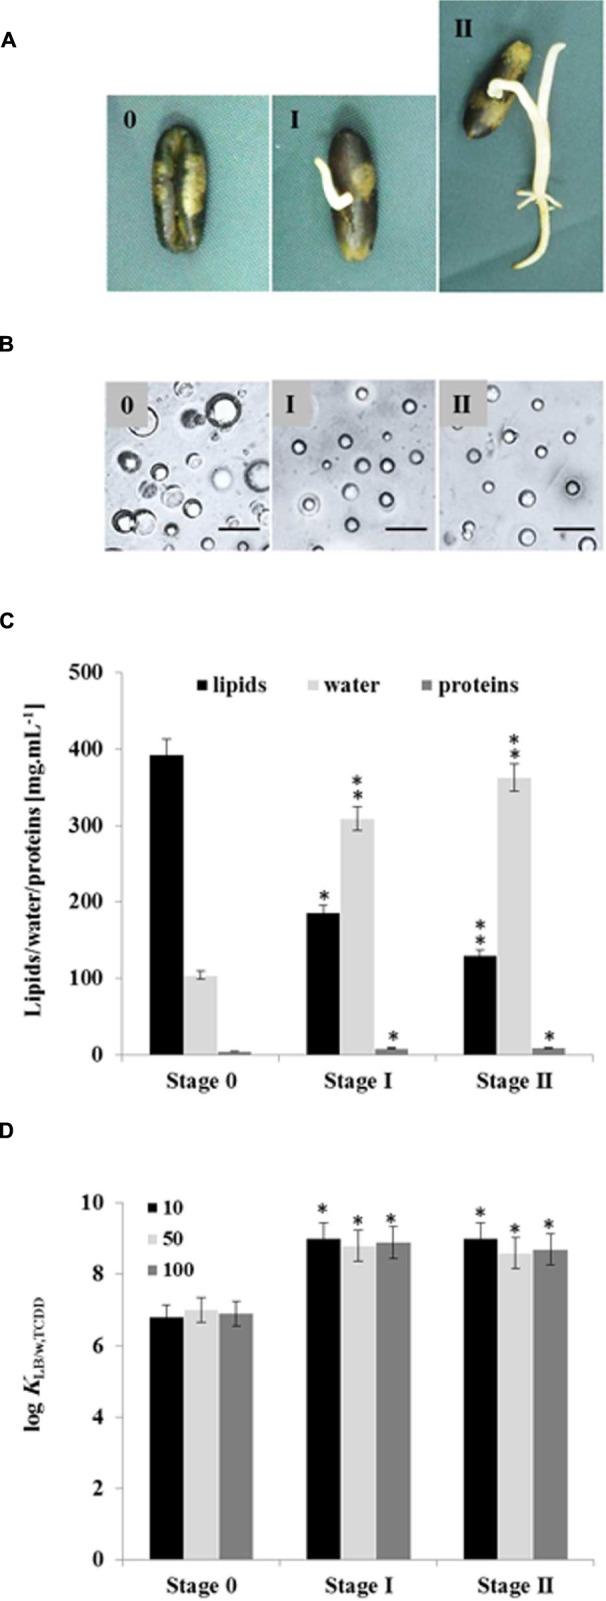
Quantitative and qualitative effects of germination on seed LDs and their subsequent bioaffinity toward TCDD.
(A) Seedlings with a radicle length of 0.5 or 2 cm were referred as stages I and II, respectively, were compared with non-germinated seeds (stage 0). (B) Light micrographs of the isolated LDs from stages 0, I, and II. Recovered LDs suspended in 100 mM potassium pyrophosphate at pH 7.4 were observed under a LEICA MPS60 microscope and the images taken at magnification of 40×. Bar represents 5 mm. (C) Biochemical composition of the recovered LDs from indicated stages. Analysis of lipids, water and proteins contents were done in triplicate. (D) TCDD-partitioning into LDs isolated form stages 0, I, and II. Three separated sorption experiments were carried out and the subsequent analysis of extracted TCDD by HR-GC/MS was done in triplicate. Thus the partition coefficient was expressed as a function of the lipid content in the LDs of stages I and II. Data are mean values ± SD (n = 6). Statistical significance was evaluated by ANOVA analysis. Asterisks indicate significant differences between stage 0 and stages I and II: ∗P < 0.05 (significant); ∗∗P < 0.01 (very significant).